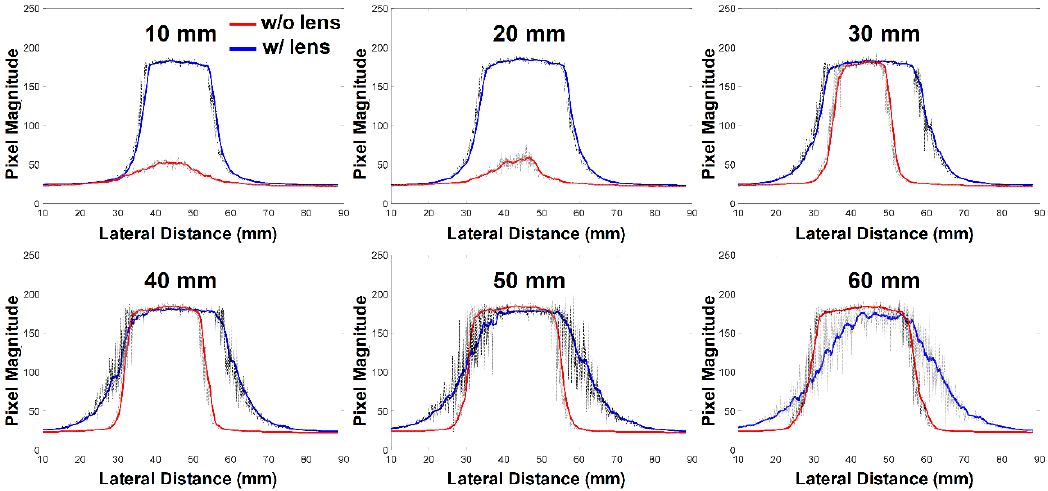
Figure 8. Light-intensity profiles measured along horizontal axis (i.e., imaging depth), indicated by the black dashed lines in Figure 7. The red and blue solid lines represent the moving averaged light intensities, without and with the optical lenses, respectively. The black lines indicate the measurement data.